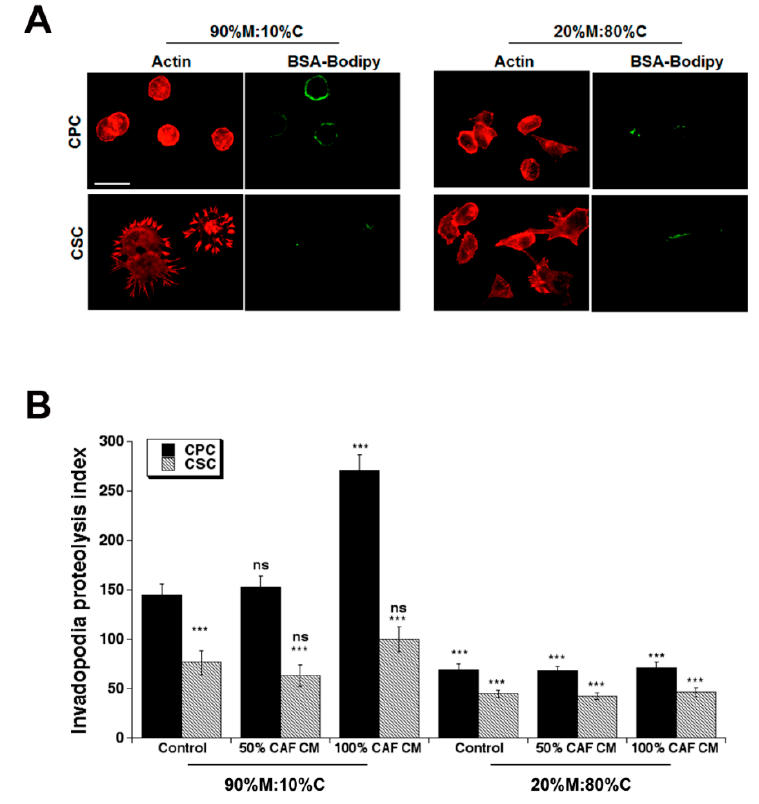
Figure 2. ECM composition modifies the effect of CAF conditioned medium on parenchymal (CPC) and CSC invadopodia ECM degradation. ( A ) Representative microscopic images of actin (red) and invadopodia-dependent proteolysis of BSA-Bodipy dissolved in the ECM (green) as described in the Methods. Scale bar represents 50 µm for all images. ( B ) CPC and CSC invadopodial proteolysis rates in organotypic cultures of 90% Matrigel:10% Collagen I and 20% Matrigel: 80% Collagen I calculated as described in Methods. Data are mean ± SEM, n = 5, ns non significant, *** p < 0.001 compared to the control for each cell line on 90% Matrigel:10% collagen I.